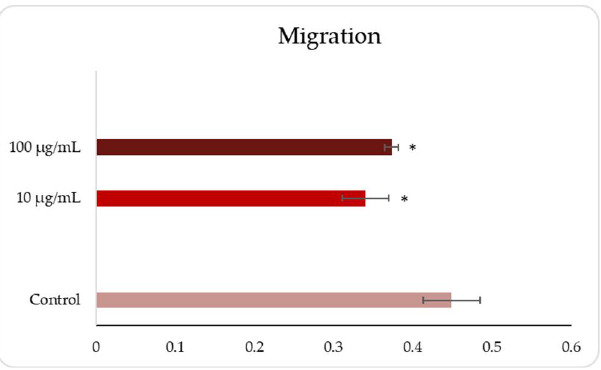
Figure 1. Effects of RJ on the migratory potential of HCT-116 cells. * statisticly significant difference between control and treatment values.